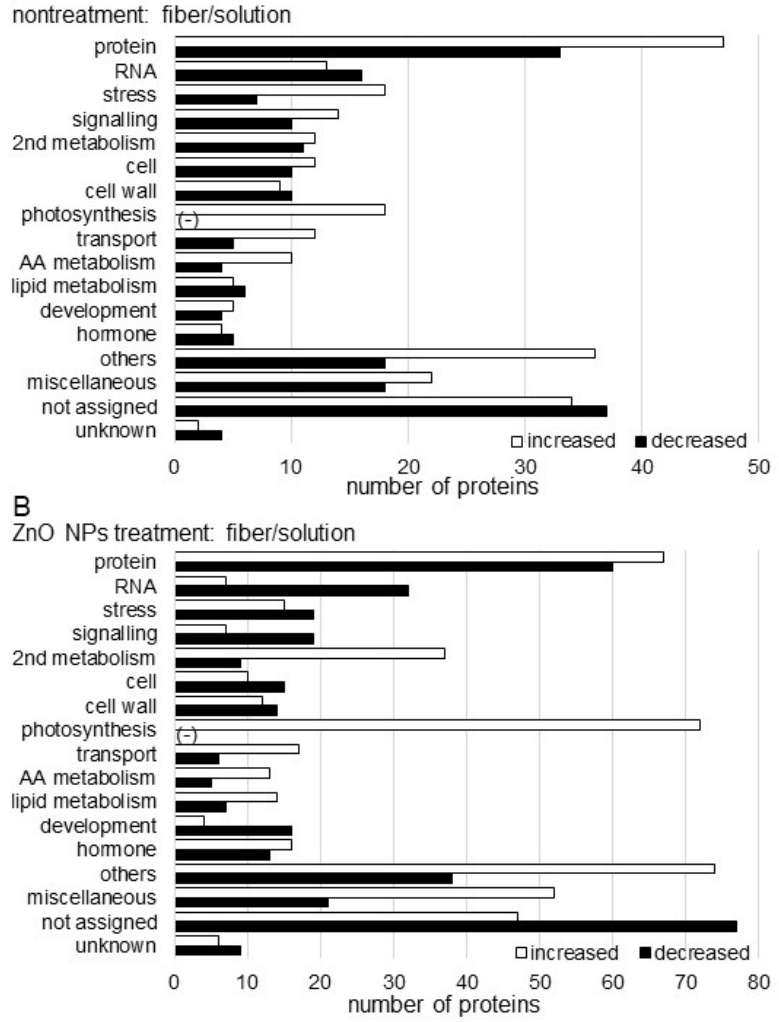
Figure 4. Functional categorization of proteins identified in the root including hypocotyl of soybean treated with ZnO NPs. Proteins extracted from roots including hypocotyl were analyzed using a LC-MS and significantly changed proteins were identified ( p < 0.05). The significantly changed proteins, 471 and 830 in nontreatment ( A ) and ZnO NPs treatment ( B ), respectively, between solution and BL-fiber, were functionally categorized using MapMan bin codes. The x -axis indicates the number of identified proteins. Abbreviations: AA, amino acid; protein, protein synthesis/degradation/post-translational modification/targeting/folding/AA activation; cell, cell division/organization/vesicle transport; RNA, RNA metabolism; hormone, hormone metabolism; 2nd metabolism, secondary metabolism; and others, nitrogen metabolism/metal handling/tetrapyrrole synthesis/oxidative pentose pathway/minor carbohydrate/cofactor and vitamin metabolism/gluconeogenesis. The negative sign shows that there is no identified protein in the respective functional category.